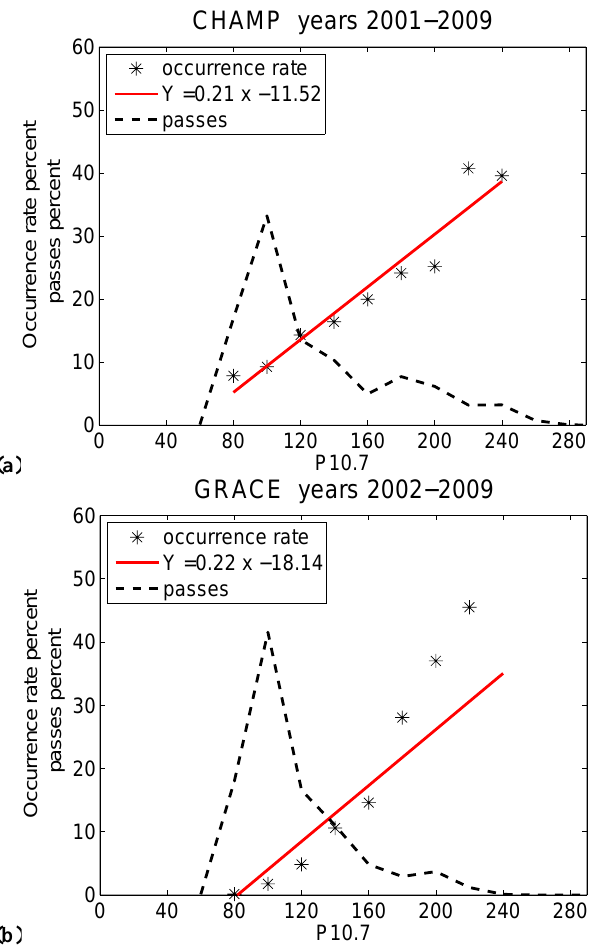
Fig. 7. Occurrence rate of EPBs versus solar flux index P10.7 based on CHMAP (top) and GRACE (bottom) observations. The dashed curve represents the percentage of the equator passes within a cer- tain solar flux level bin, and the straight solid line represents the linear fit to the occurrence rates over the range P10.7=80...200sfu.